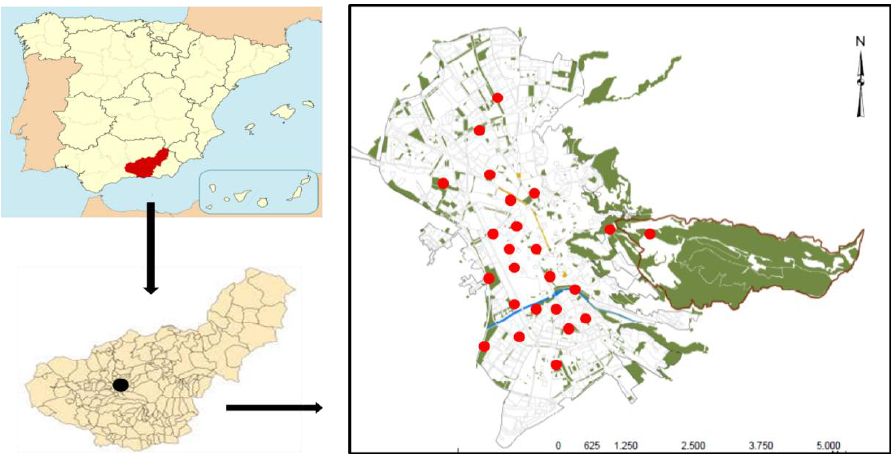
Figure 1. Location of the city of Granada along with the location of the 24 urban green spaces considered in this study